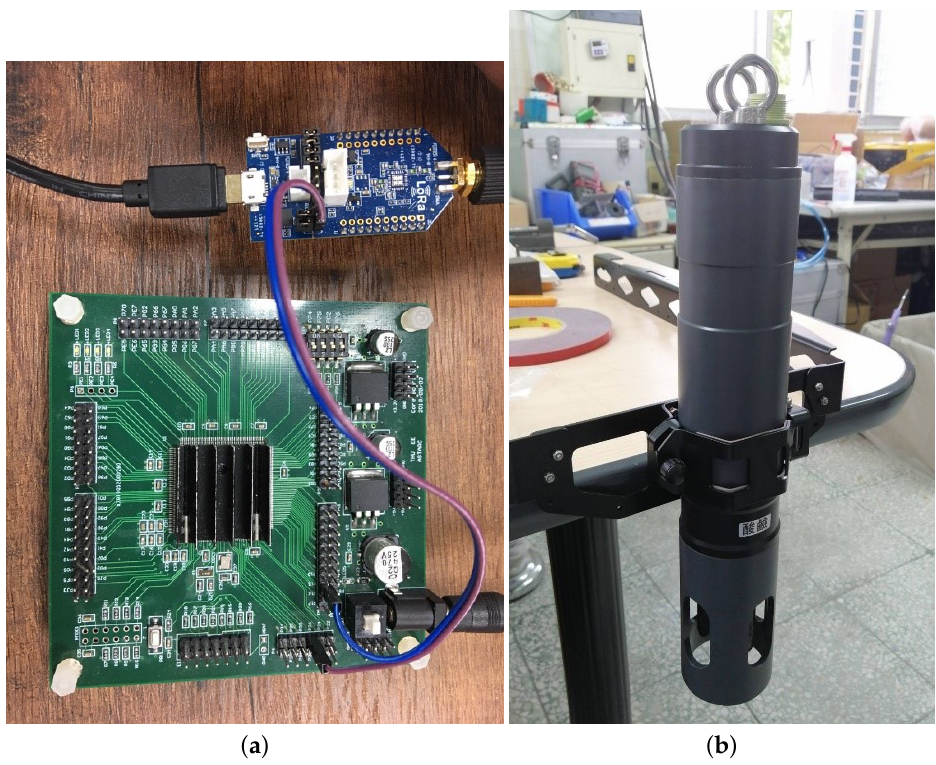
Figure 9. LoRa and Water Multi-sensor: ( a ) The total connection diagram of with LoRa module of EK-S76SXB; ( b ) Multi-parameter Water Quality Sensor.